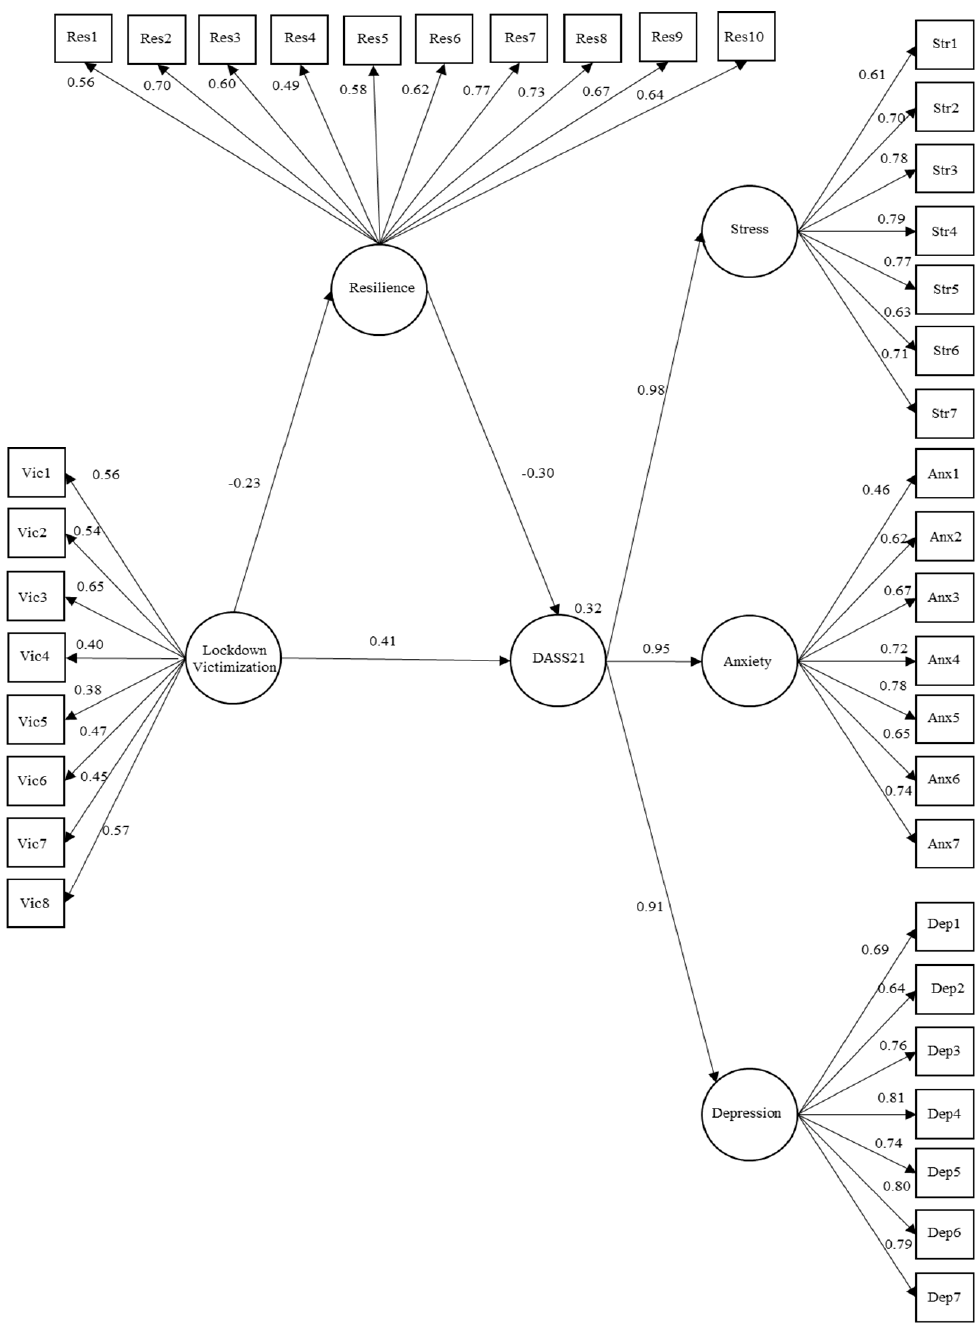
Figure 1. Structural equation global